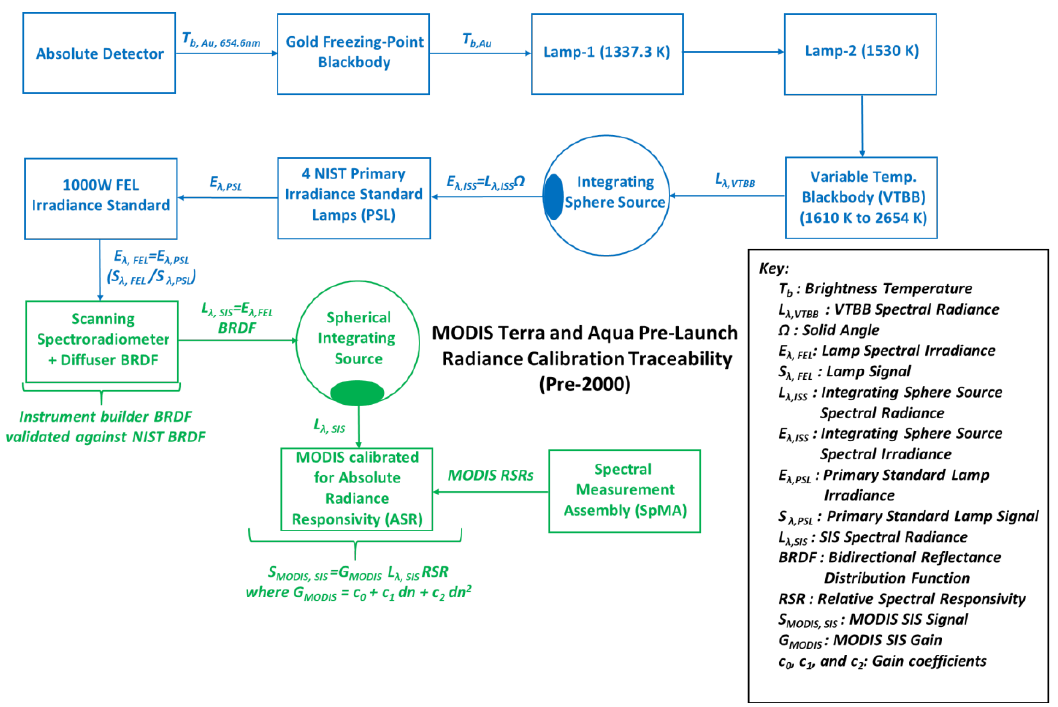
Figure 2. MODIS reflective solar bands (RSB) pre-launch radiance calibration traceability .